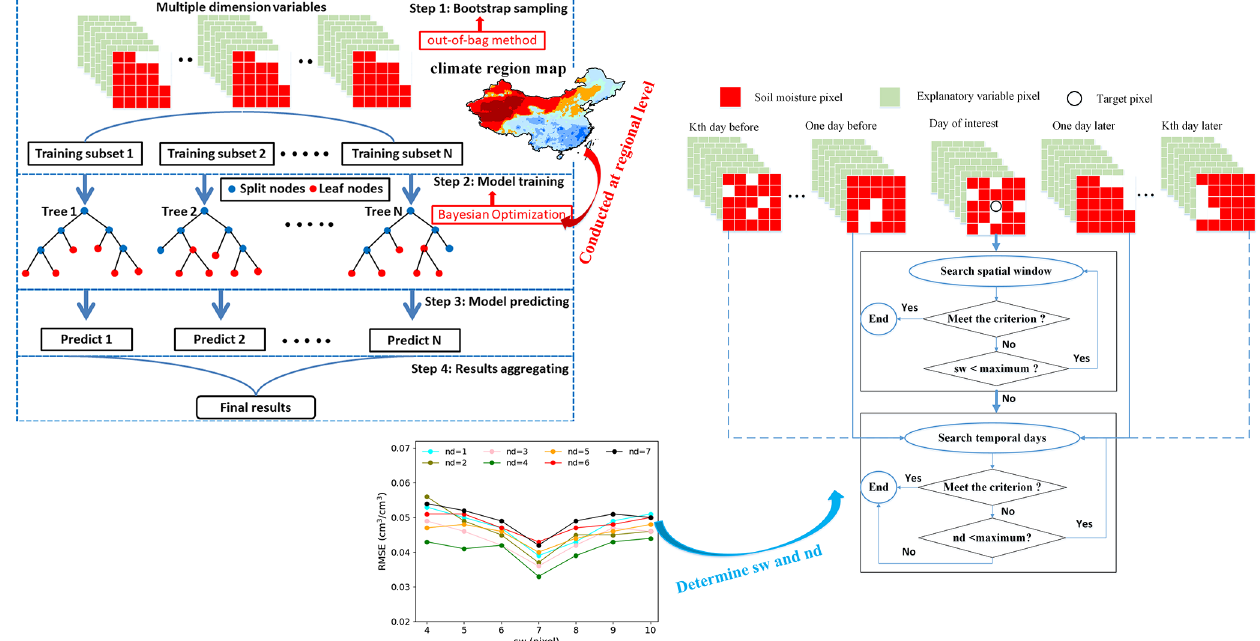
Figure 4. (a) Diagram of the random forest model implemented for a multidimensional dataset. (b) Diagram of the spatiotemporal window determination strategy for random forest regression. (c) Results of the sensitivity analysis regarding two maximum values, i.e., the size of the spatial window (sw) and the number of temporal days (nd), for terminating the searching